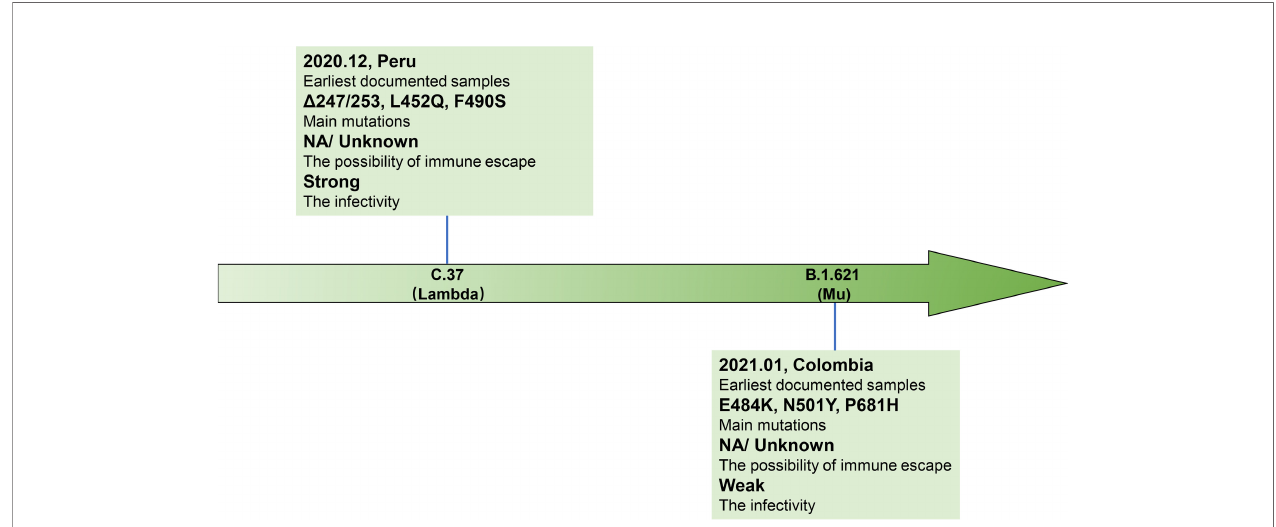
FIGURE 3 | Brief information of two VOI variants. Two VOI variants (C.37 and B.1.621) are marked in the arrow according to the date of designation, and their related brief information (e.g., the time and location of earliest documented samples, infectivity, main mutations, immune escape ability) are displayed in the corresponding